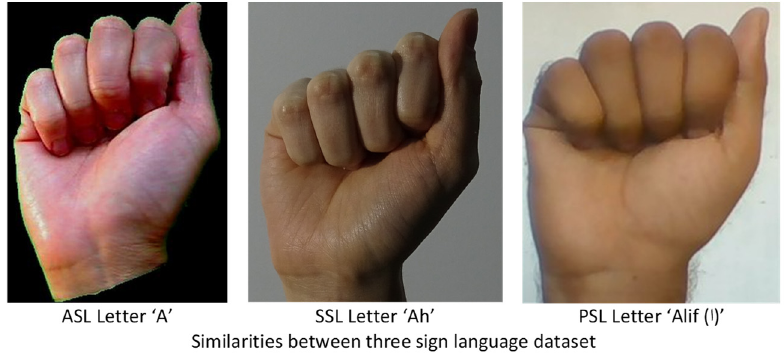
Figure 26. Similarities between different sign languages.